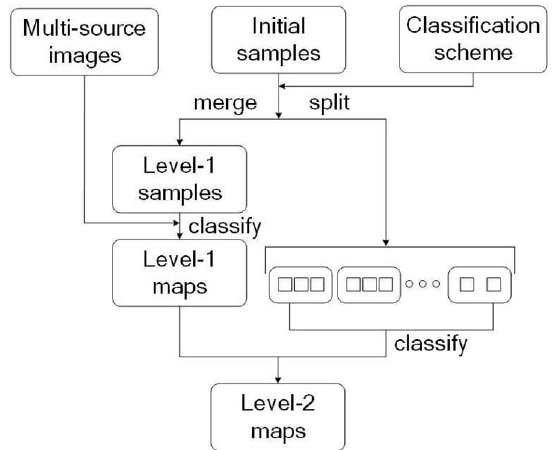
Figure 3. Illustrating the hierarchical mapping strategy.